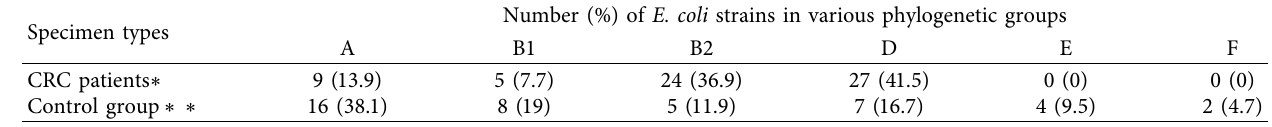
Table 2: Phylogroups distribution of E. coli isolates according to specimen